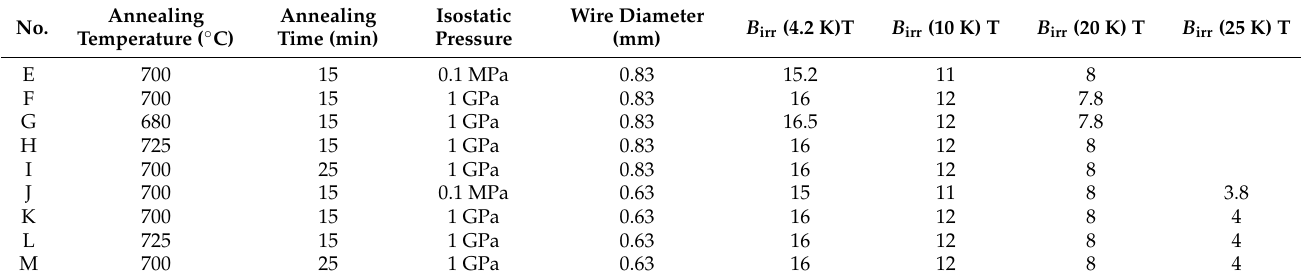
Table 2. Heat treatment parameters of the 10% SiC doped MgB 2 superconductor